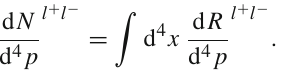
Fig. 1 The equilibrium dilepton production rates of z 2 q as a function of T / T c is shown along with its SB limit ( z q → 1). The temperature dependence of the effective quark fugacity, z q is taken from Ref.